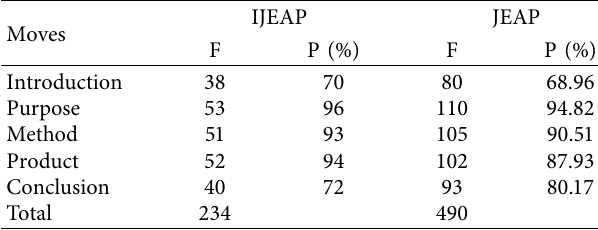
Table 1: Frequency and percentages of moves in